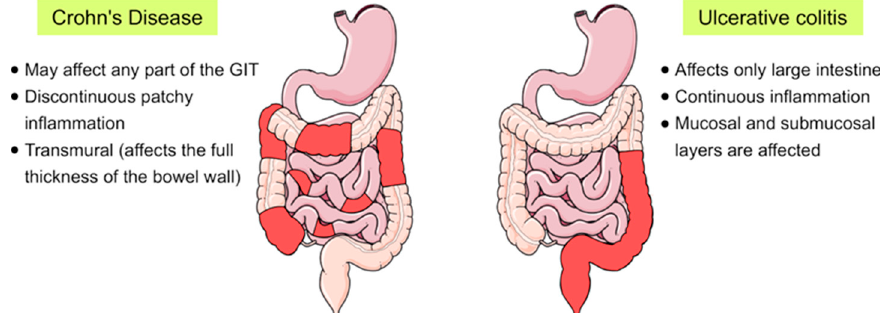
Figure 1. Schematic representation showing the main differences between the two main forms of inflammatory bowel disease (IBD), Crohn’s disease and ulcerative colitis, in terms of their location and the pattern of the affected areas (red-coloured) in the gastrointestinal tract (GIT).